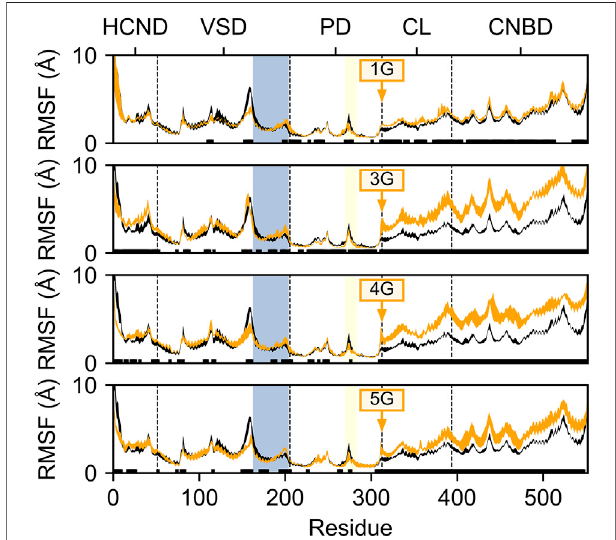
FIGURE2| Residue mobility inwildtype HCN2 and the 1G, 3G,4G, and 5G constructs. Residue-wise root-mean-square fl uctuation (RMSF) in MD simulations of HCN2 (black line) and 1G, 3G, 4G, and 5G (orange lines, from top to bottom). The thickness of the lines represents the standard error across all subunits ( n = 4). Residues with signi fi cant differences ( p < 0.05) between HCN2 and the respective construct are indicated with a black bar above the x -axis. Residue numbers are according to the AMBER numbering; domains are denoted above the plots; domain boundaries are indicated by a vertical dashed line. The S4-helix in the VSD is marked with a blue background, and the glycine insertion site is indicated with an orange arrow. For consistency, RMSF values for the glycine insertions were omitted from each subplot.